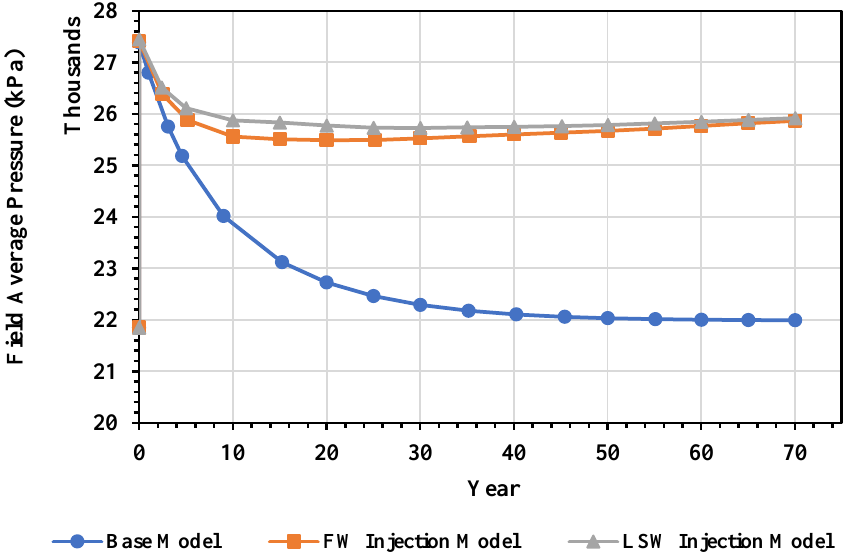
Figure 9. The average pressure evaluation of the base, FW injection, and LSW injection models of the Kashkari oil field.